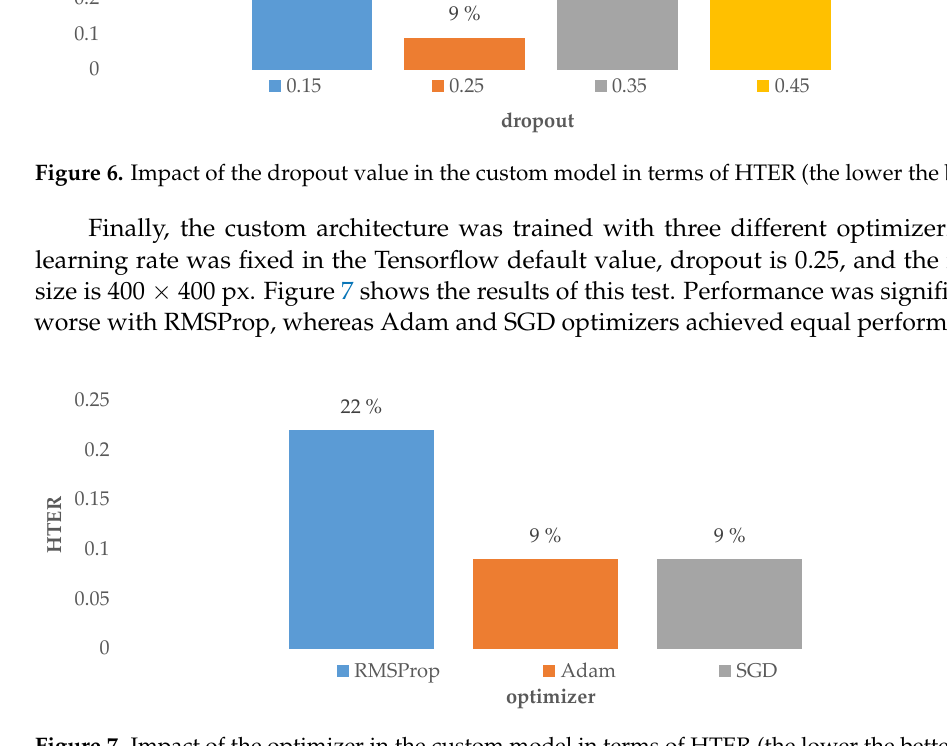
Figure 7. Impact of the optimizer in the custom model in terms of HTER (the lower the